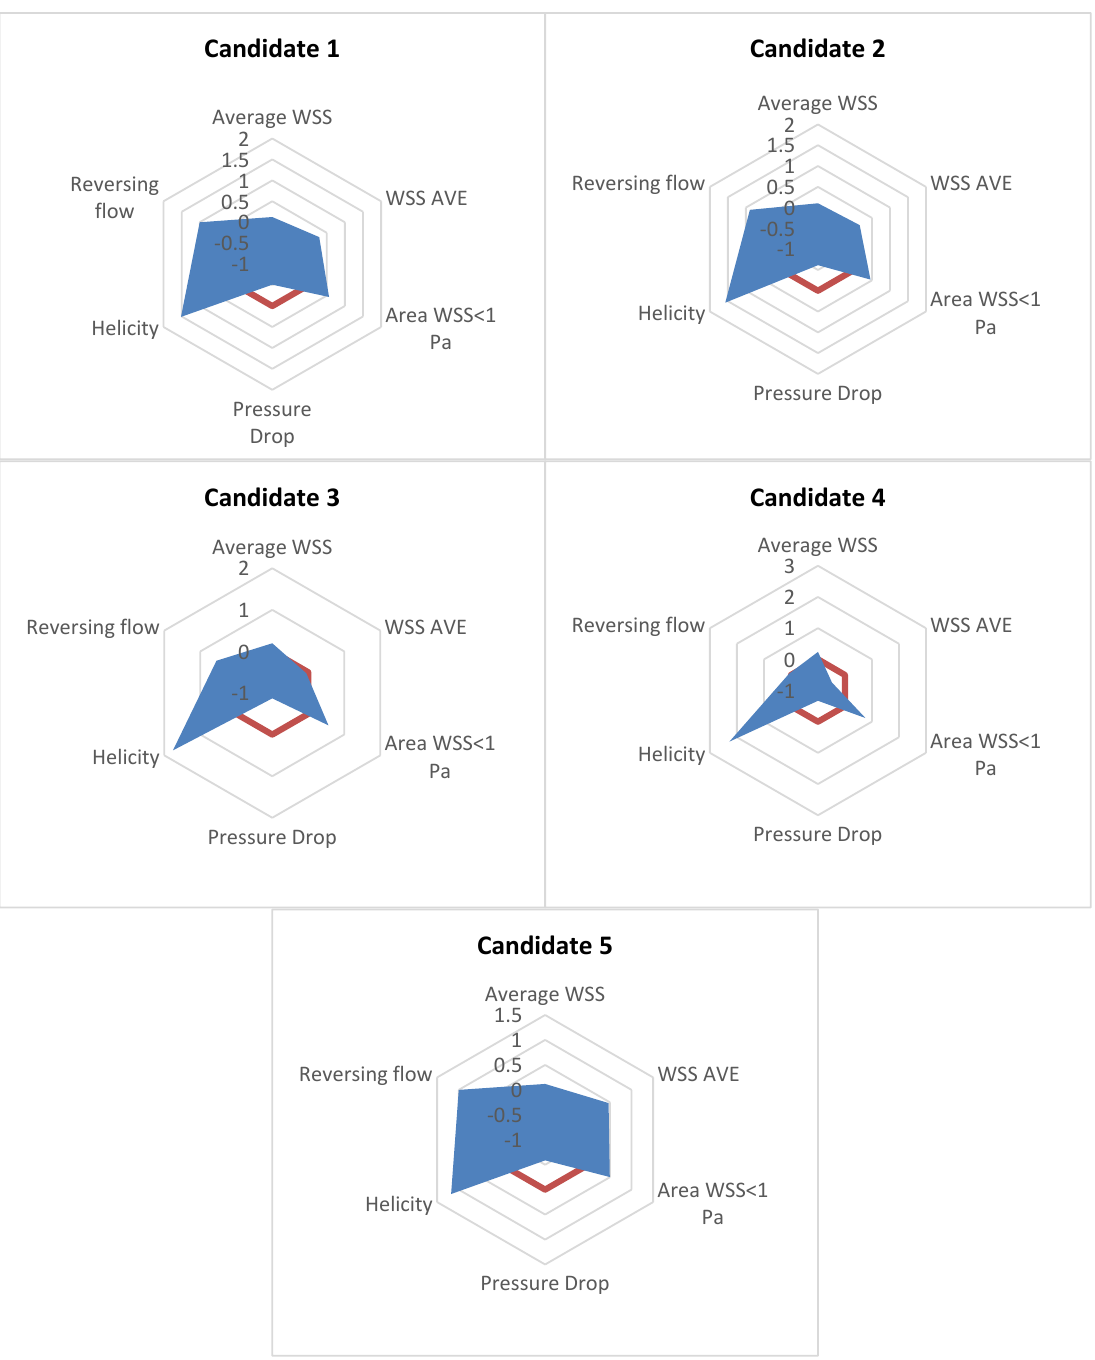
Figure 2. Comparison of the different candidates’ performances compared with the reference case with no ridge (red line): positive values denote improved performance compared with the reference solution. Please refer to Table 4 for the scale/numbers shown in each figure.